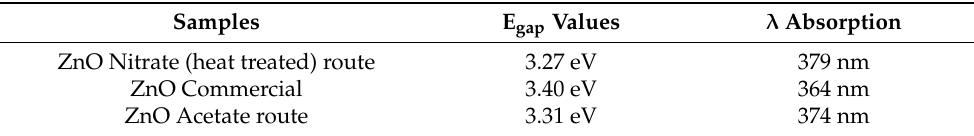
Table 3. E gap values obtained from the graphical representation of the Tauc Plot. Values were extrapolated from the slopes in the flat section to y =